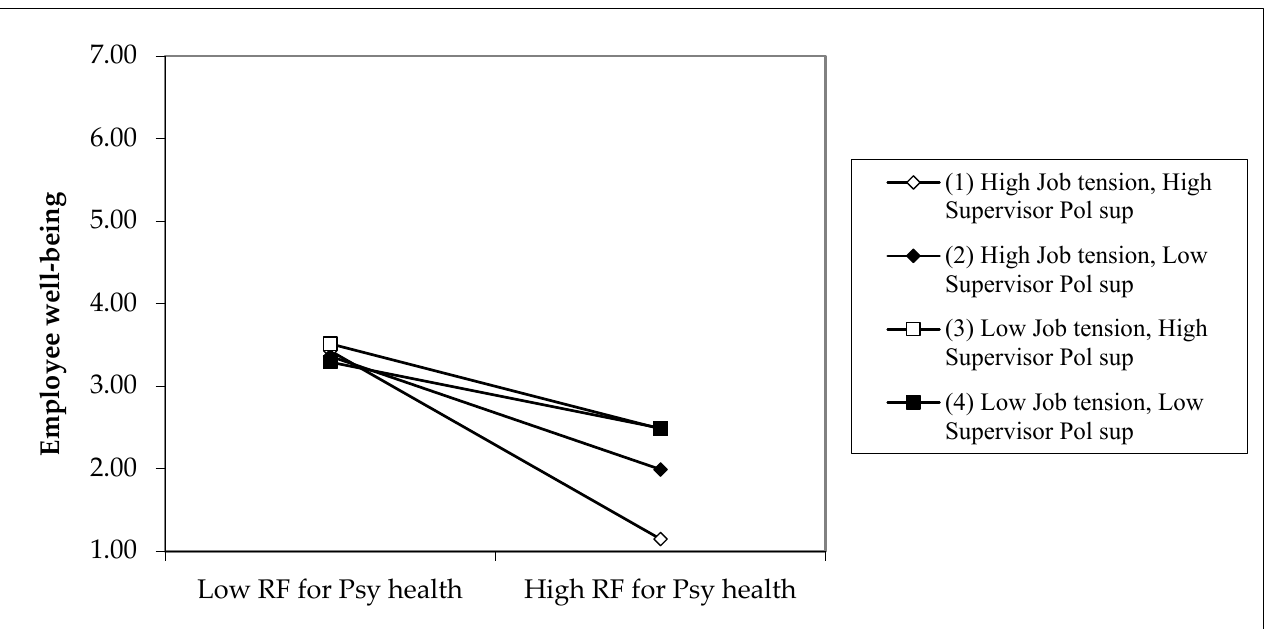
Figure 2. Sample 2: Three-way interaction of risk factors of work on psychological health, job tension, and supervisor political support predicting employee well-being. Note: Calculations are based on coef- ficients from Table 3 .